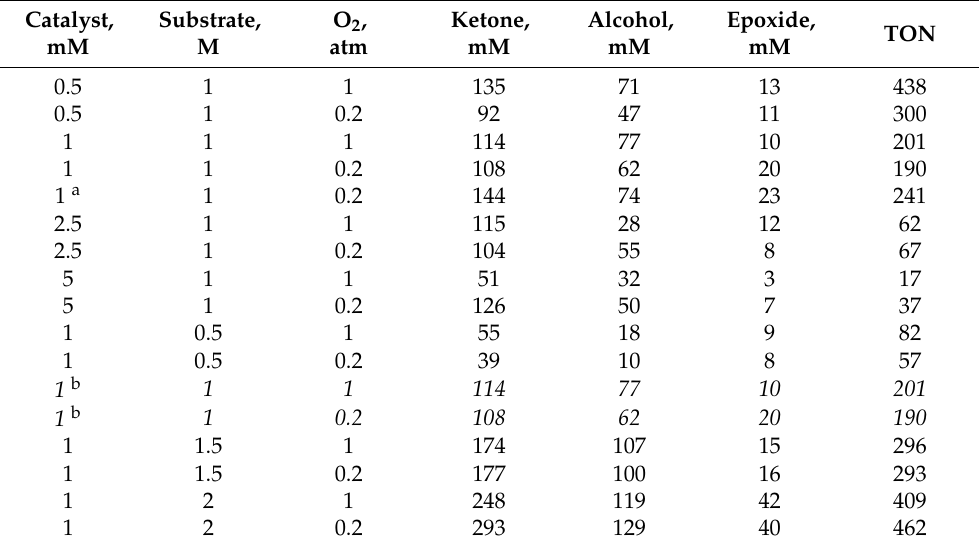
Table 1. Oxidation of cyclohexene with dioxygen (p O2 = 1 atm) and air (p O2 = 0.2 atm) catalyzed by [(N4Py)Fe II ] 2+ in MeCN. Reaction time 24